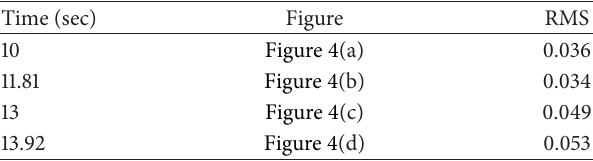
Table 2: Computational error.